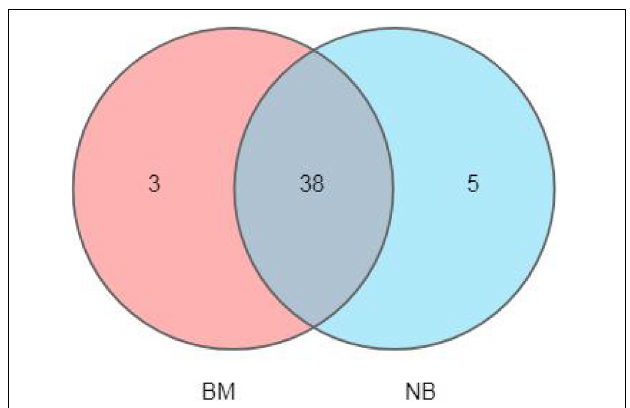
FIGURE 1 | Venn diagram of fungal diversity of Mianning hams.